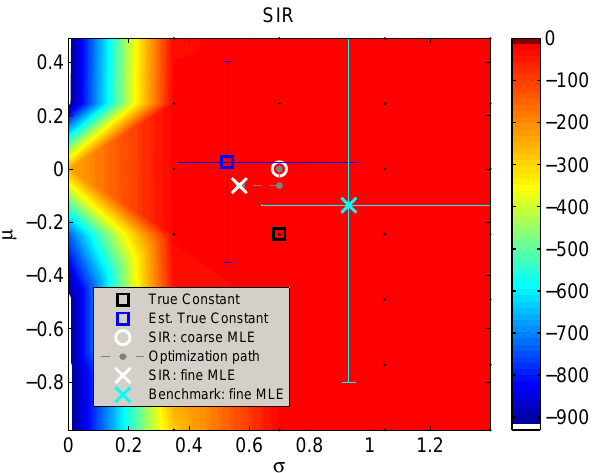
Fig. 9. Log-likelihood contour levels of the SIR filter for a simula- tion of a 10-event point process. Same explanation as for Fig.